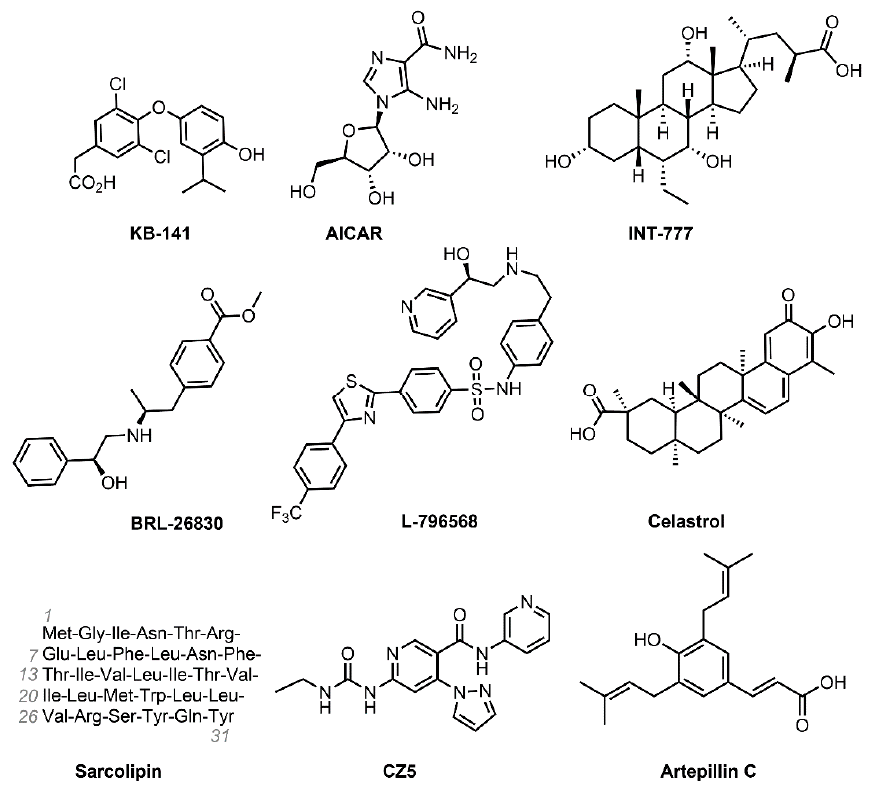
Figure 4. Drugs under development that increase energy expenditure. Figure 5. Drugs under development that increase energy